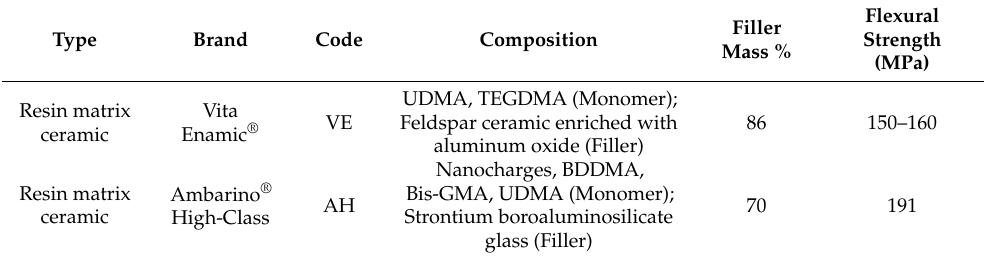
Table 1. Composition and properties of CAD/CAM blocks examined as published by